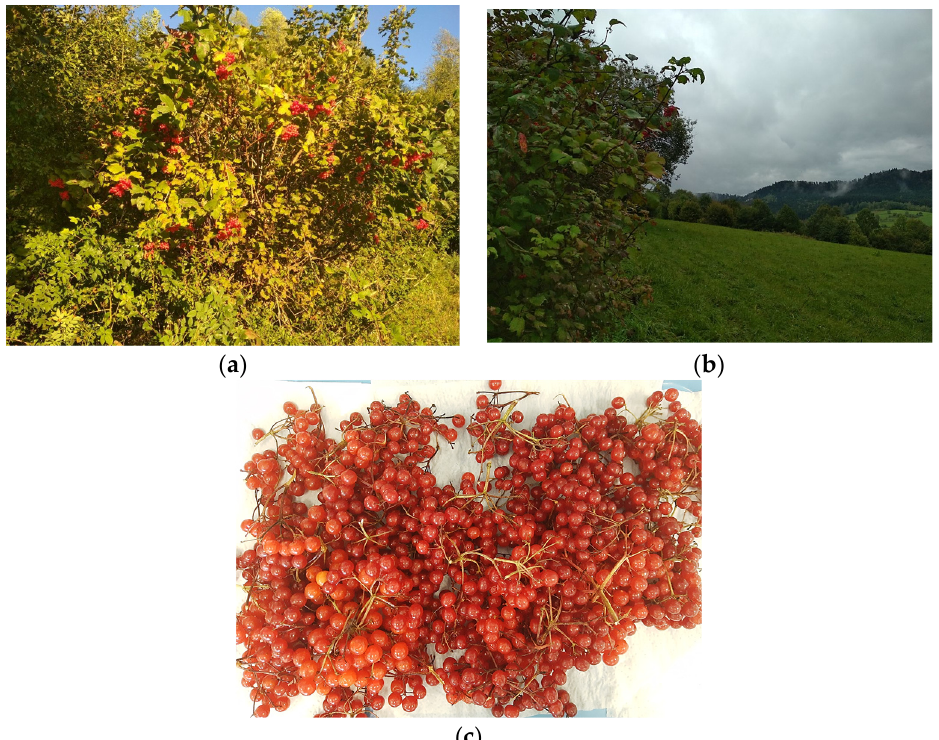
Figure 1. Guelder rose shrub. Liszna near Sanok. Author D. Sokó ł ( a , b ). Guelder rose fruit before freezing. Author M. Mazur ( c ).